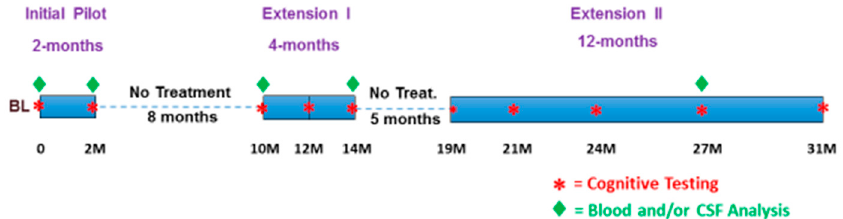
Figure 2. The treatment (blue bars), cognitive testing, and blood/CSF analyses for this 31-month study of TEMT safety and efficacy.